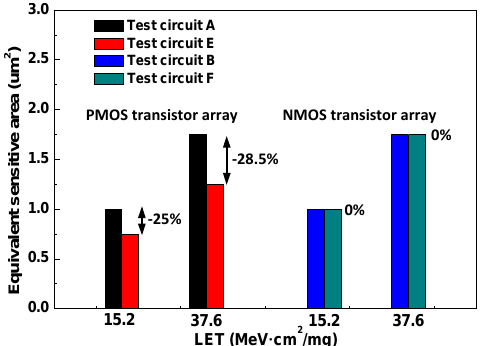
Figure 8. Effect of well contacts on the measured ion-induced sensitive area with different LET values. Test circuit A and B have the normal connections of target transistors. The well connections are added beside the target transistors in test circuit E and